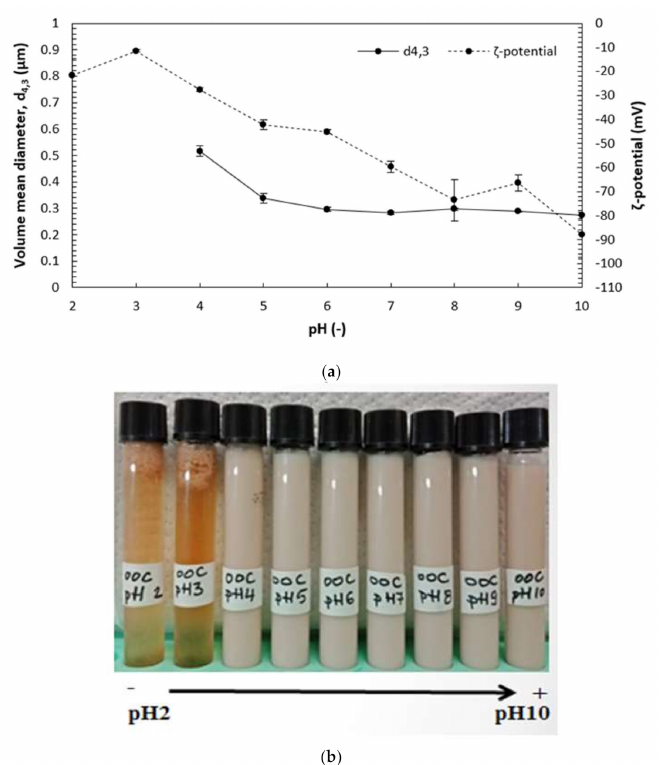
Figure 6. ( a ) Effect of pH on the volume mean droplet diameter ( d 4,3 ), ζ -potential and ( b ) visual appearance of O/W emulsions prepared using OOC 80% aqueous ethanolic extract.